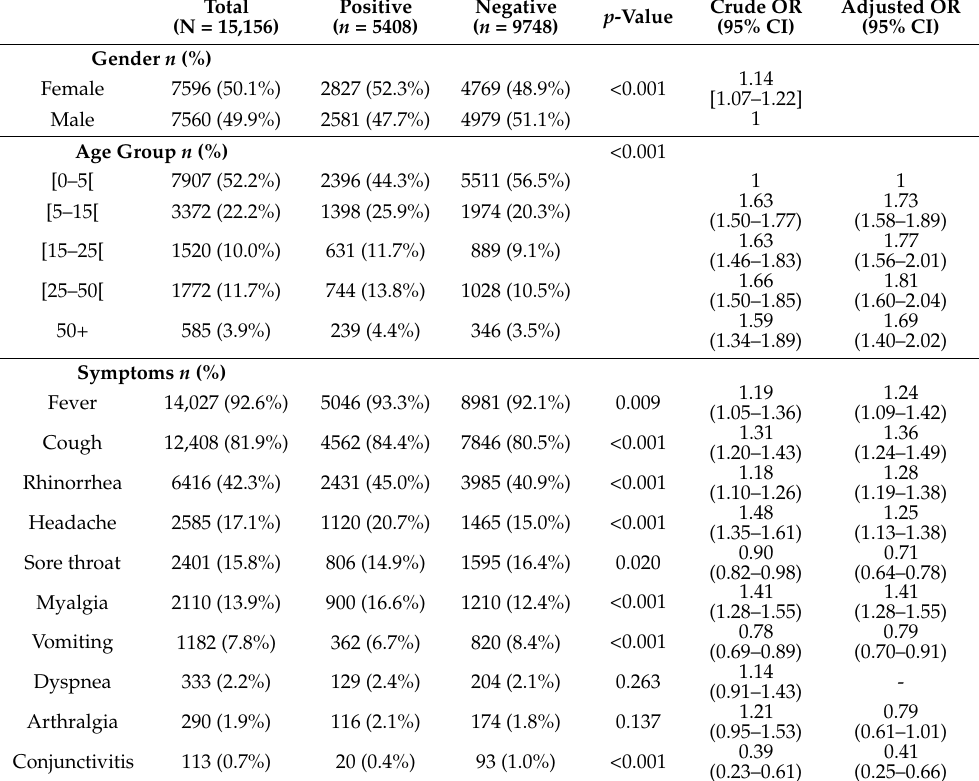
Table 1. Characteristics of patients presenting ILI and or SARI symptoms according to influenza infection. Senegal